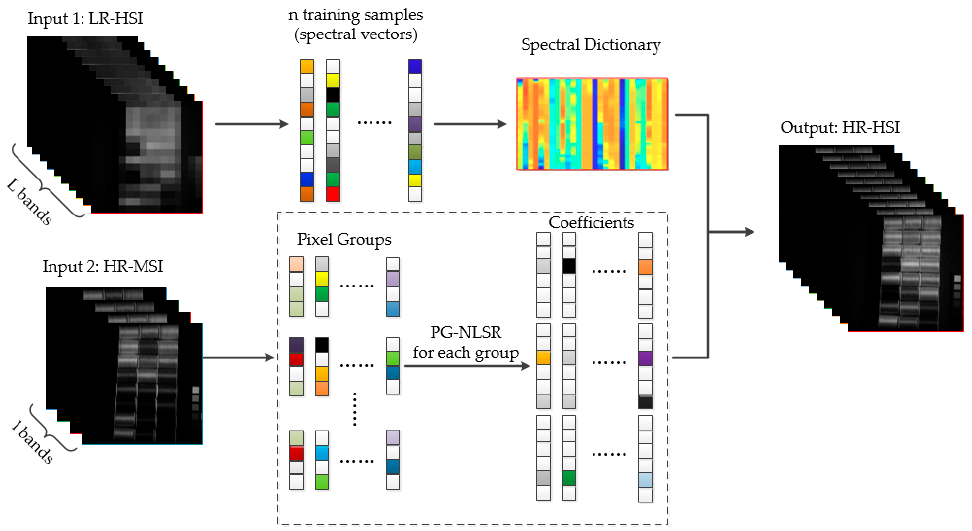
Figure 4. Flowchart of the proposed HSI and MSI fusion approach.